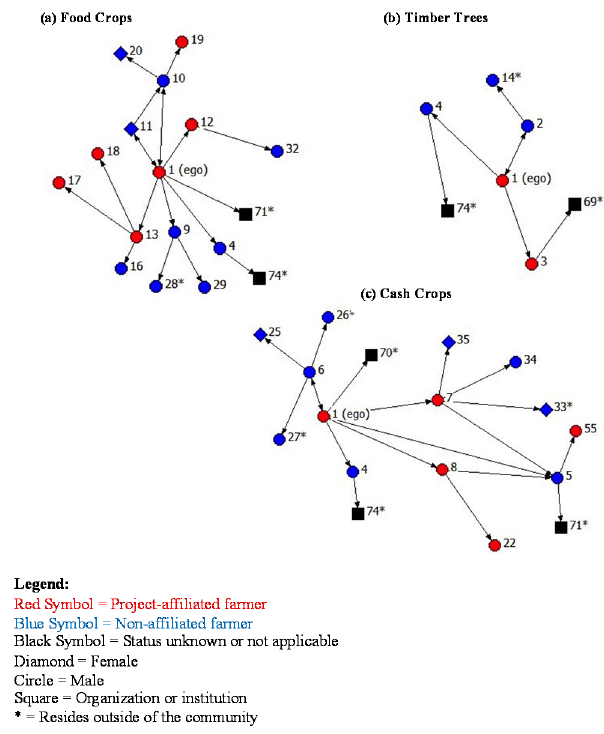
Figure 1. Examples of crop-specific sociograms for a project-affiliated male ego (starting point respondent), including network members that are two steps from the ego. Knowledge network composition and size is distinctly variable across network type, where the food crop and cash crop knowledge networks (( a ) and ( c )) are largest, followed by the timber tree network ( b ), which is smaller.